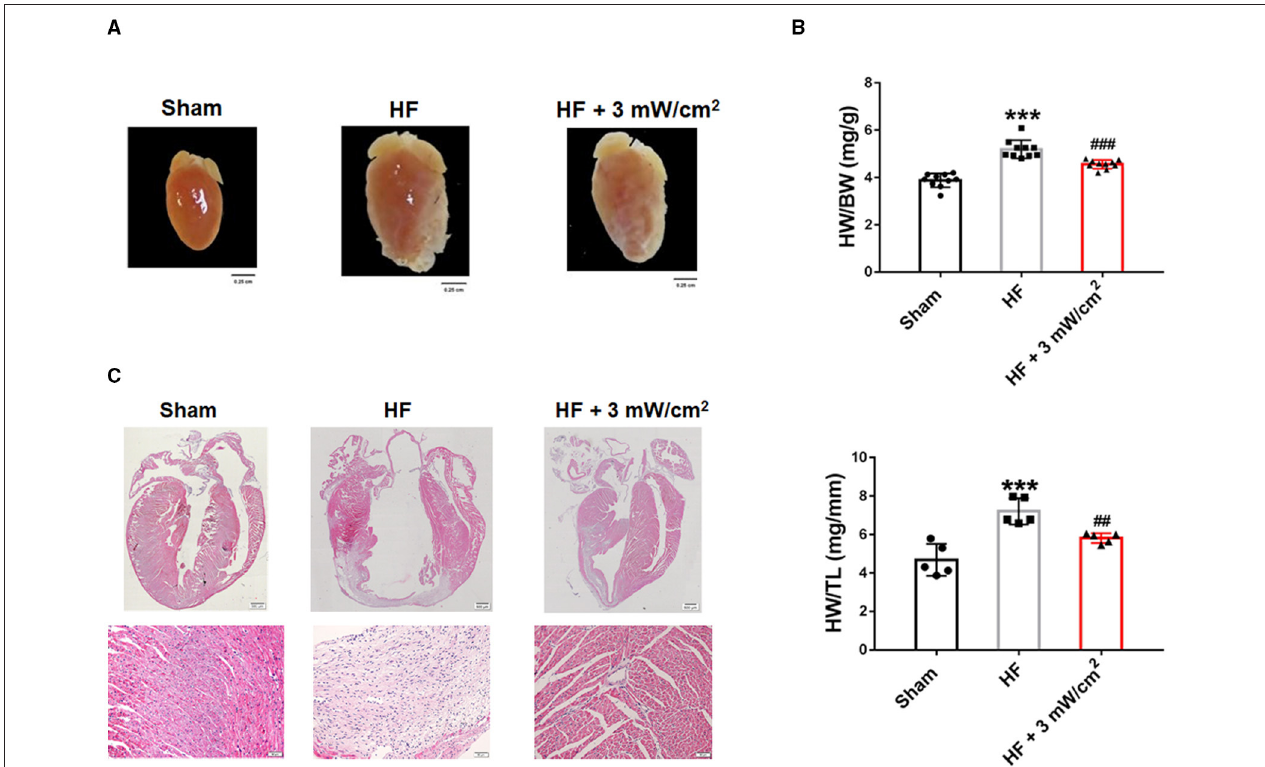
FIGURE 2 | LED-Red therapy inhibits myocardial remodeling in mice with heart failure. (A) Gross morphology of hearts. Scale bar = 0.25cm. (B) Heart weight to weight ratio (HW/BW) of mice, n = 10. Heart weight to tibia length (HW/TL) of mice, n = 5. (C) Myocardial remodeling of mice by HE staining. Scale bar = 500 µ m (upper panel), 50 µ m (lower panel). *** P < 0.001 vs. Sham, ## P < 0.01 vs. HF. Data are expressed as the mean ± SEM.